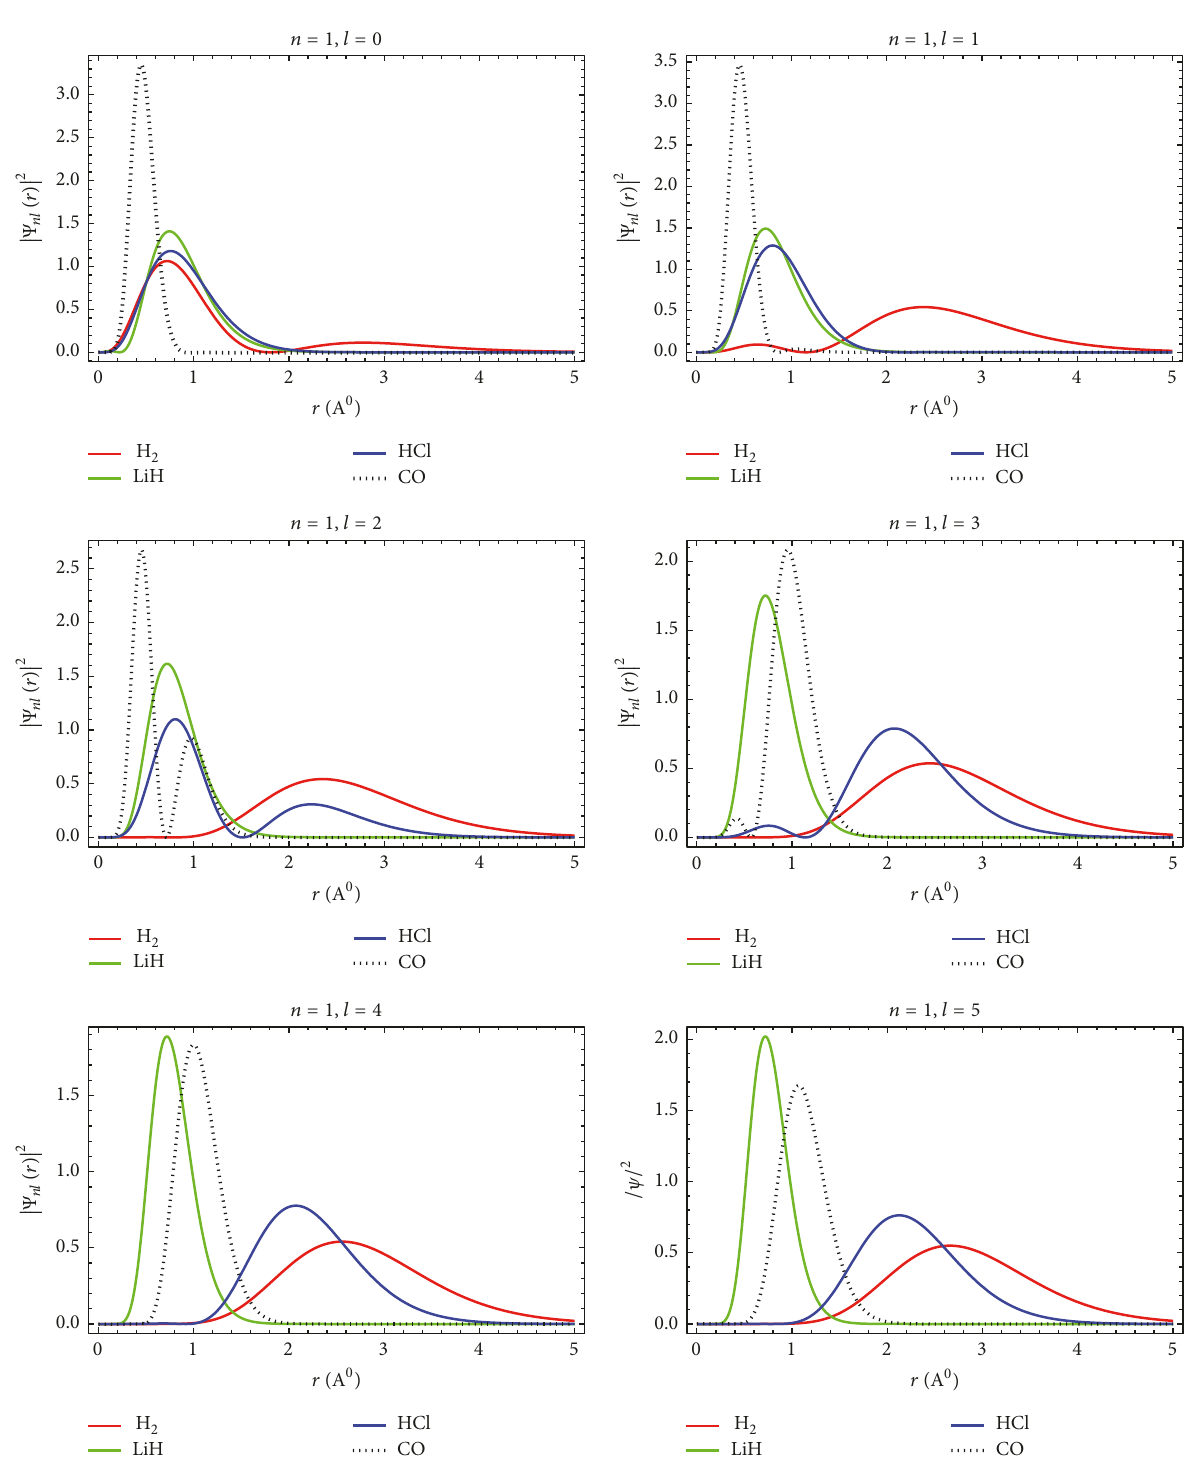
Figure 9: Probability density plots for the interaction potential with orbital angular quantum number 𝑙 = 0, 1,2, 3, 4 , and